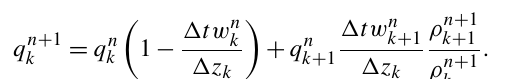
run is lower by 25 %–30 % on average over the ME in